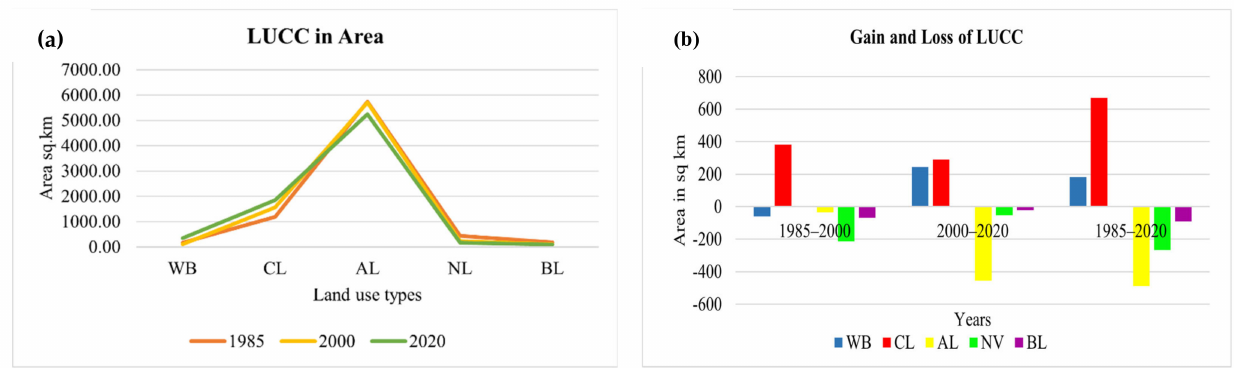
Figure 6. LUCC change and gain and loss estimation of the study area under different time periods; ( a ) LUCC in area (km 2 ) of 1985, 2000, 2020; ( b ) gain and loss over different periods between 1985–2000, 2000–2020, and 1985–2020.